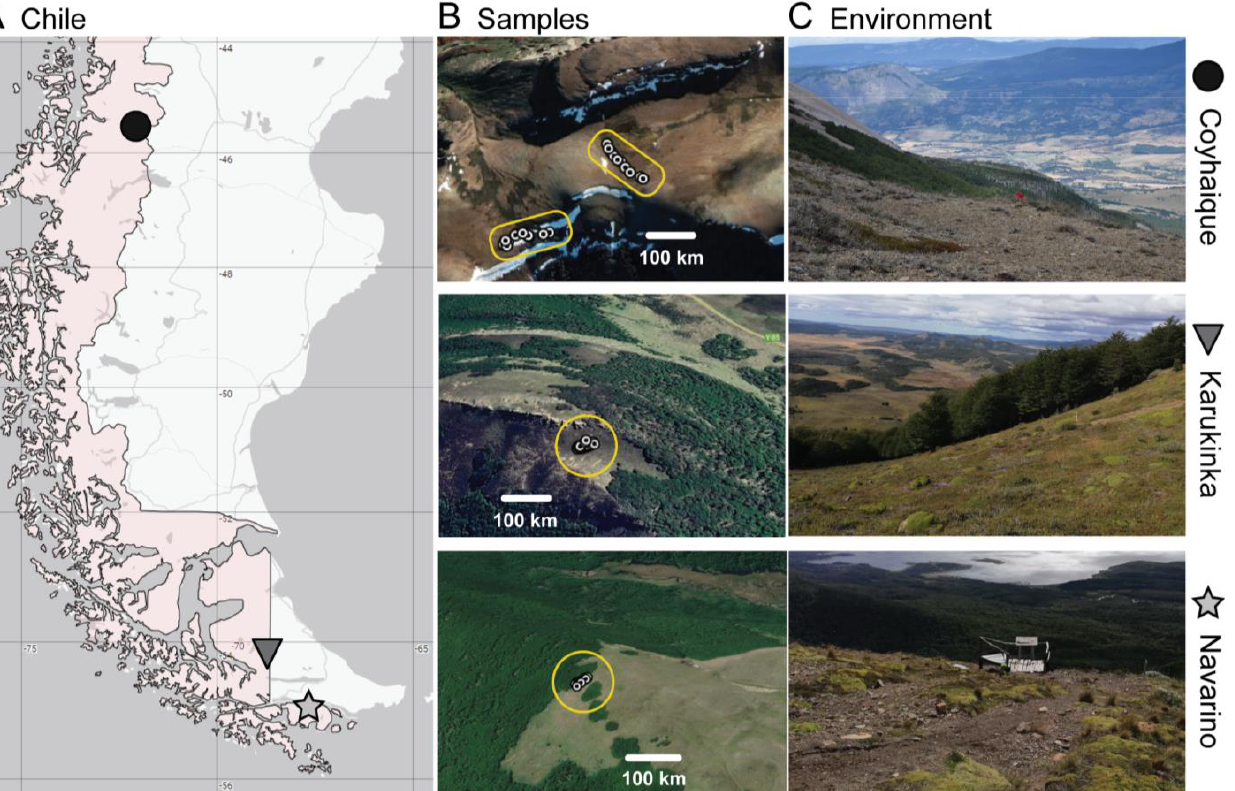
Figure 1. Study sites and lichen samples. ( A ) Geographic location of the three sampling sites. ( B ) Sample collection transects at each site (collection area in yellow). ( C ) Panoramic views of the sampling sites.